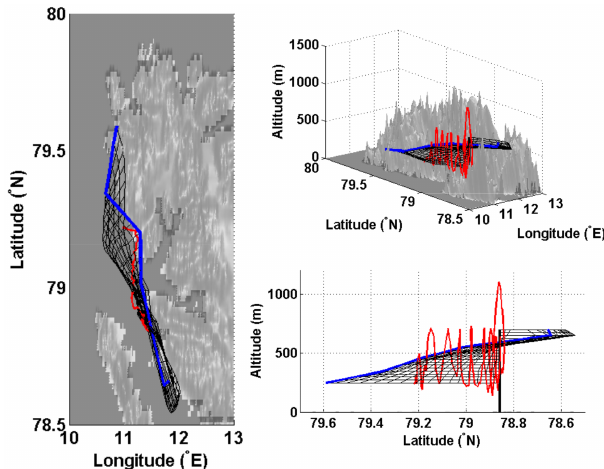
Figure 12. Wind field calculated from the CMET balloon flight 5. Air parcel trajectories are calculated over an 8h period for each 50m altitude layer according to the winds observed by the CMET soundings. The red line shows the actual balloon track, the black vertical line shows the initialization of the calculation and the de- rived air parcel trajectories (wind field grid) are shown in grey. The blue line shows the final locations after